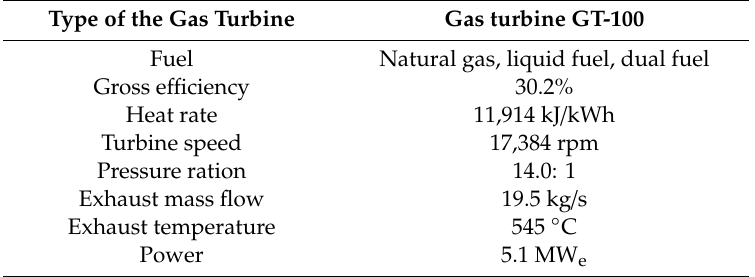
Table 1. Basic technical parameters of the GT-100 gas turbine. Source: Own study based on [51].